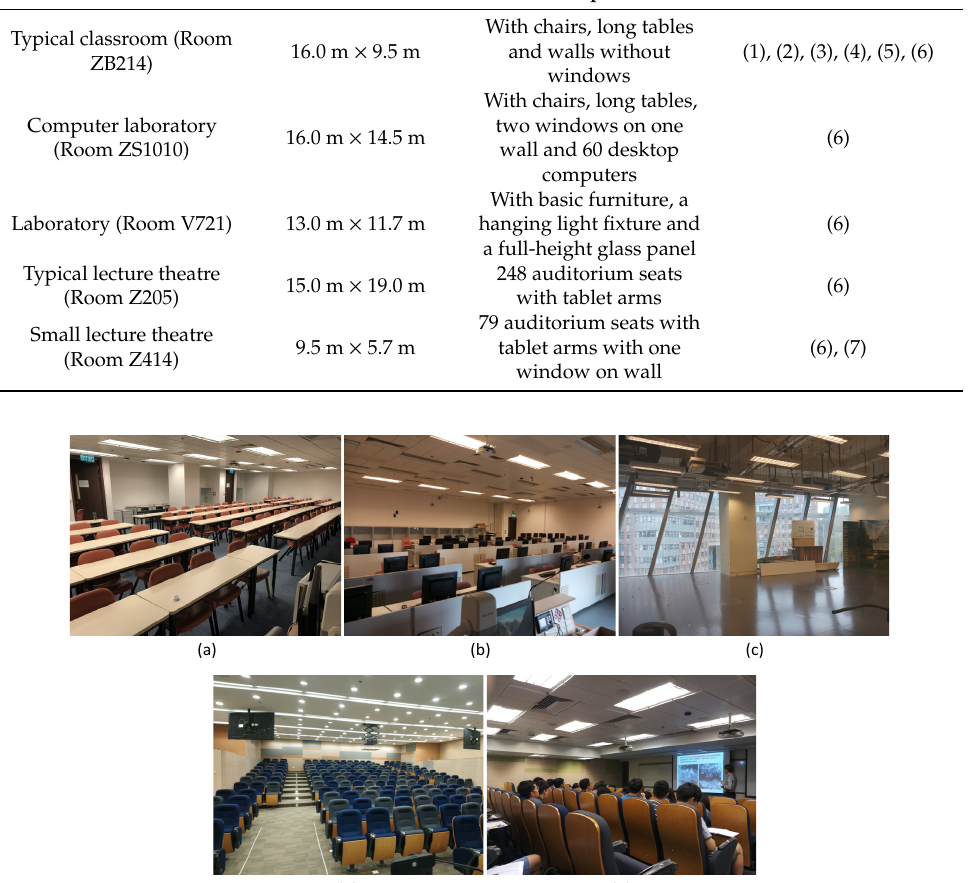
Figure 5. Experimental environments. ( a ) Typical classroom (Room ZB214). ( b ) Computer laboratory (Room ZS1010). ( c ) Laboratory (Room V721). ( d ) Typical lecture theatre (Room Z205). ( e ) Small lecture theatre (Room Z414).